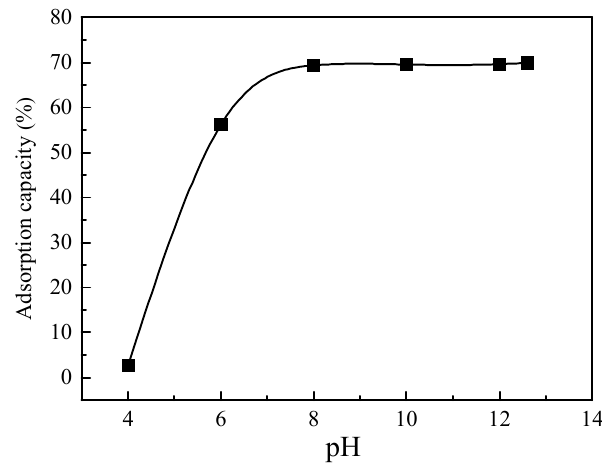
Figure 4. Adsorption capacity of chromium at different pH values. Table 3. Speciation distribution of Cr(VI) forms in the leachate before and after